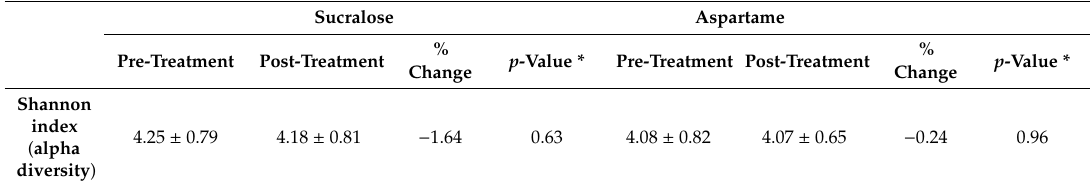
*ComparisonbyLinearMixedE ff ectsModelbetweentreatmentgroups. Valuesareexpressedasthemeans ± standard deviations (SDs).